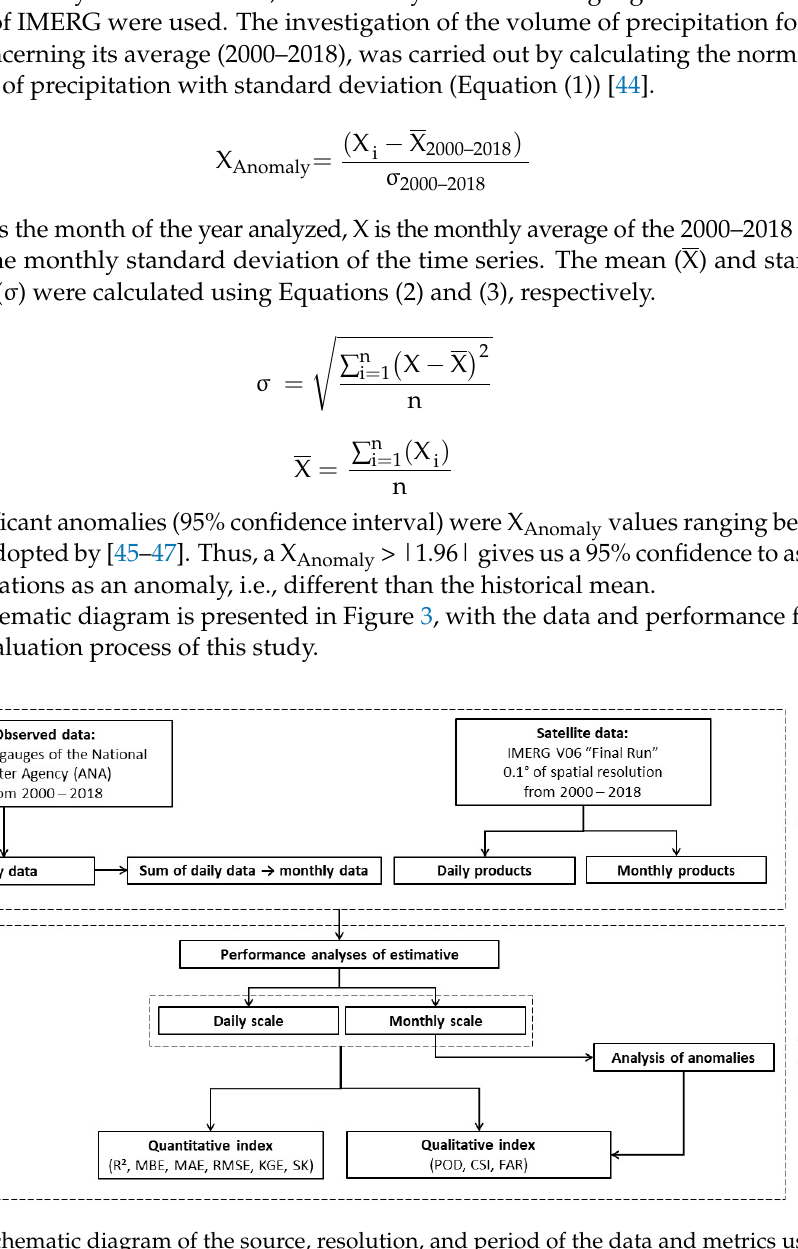
Figure 3. Schematic diagram of the source, resolution, and period of the data and metrics used for evaluation of the precipitation estimative by IMERG products.